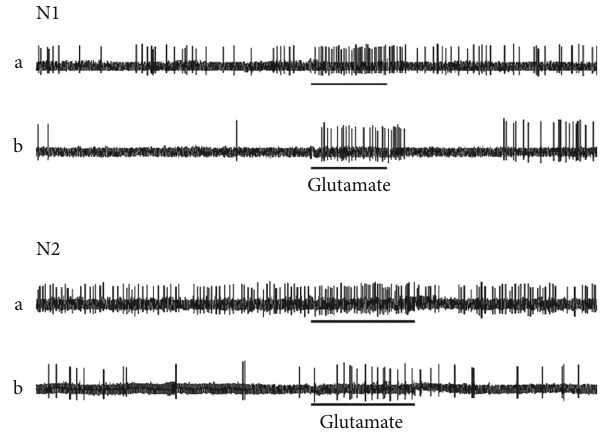
Figure 1: Sodium thiopental and e ff ectiveness on the condition of the nervous system (source: [12]).